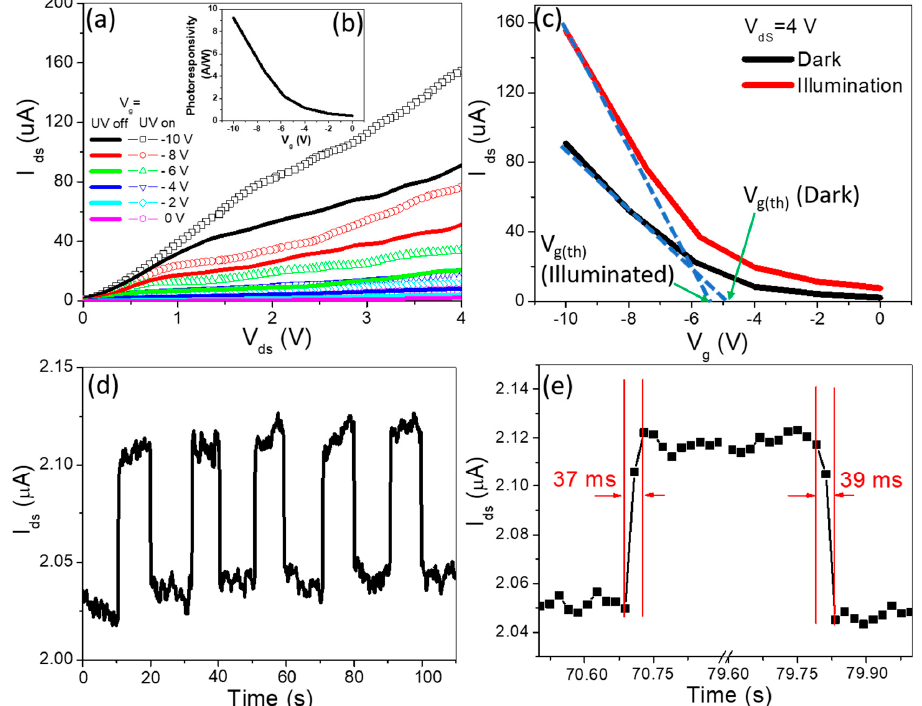
Figure 5. ( a ) I ds –V ds output curves of the MoS 2 PFET under ultraviolet ( λ = 365 nm) illumination (symbols lines) and in dark conditions (solid lines) with varying gate voltages. ( b ) Photoresponsivity as a function of V g at V ds value of 4 V. ( c ) I ds –V g graph displaying transfer behavior of the MoS 2 PFET for V ds = 4 V under dark and UV illumination. ( d ) Photoresponse of the p -type MoS 2 device revealing the stable and repeated changes in response to the light at on and off conditions at V ds = 6 V. ( e ) Photoresponse rate of the p -type MoS 2